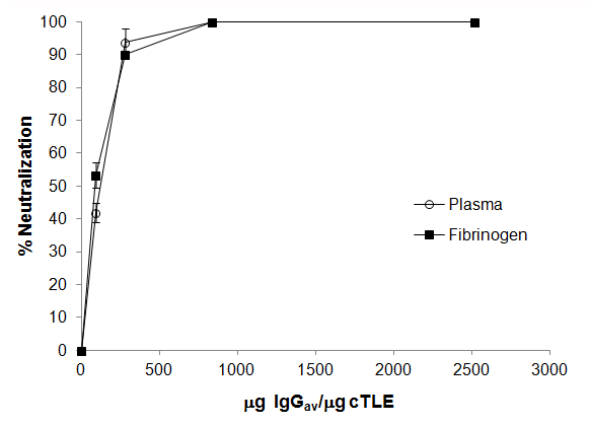
Figure 3. Neutralization of the coagulant activity of cTLE by IgG . Results are presented as mean ± S.D. av (n = 4). cTLE: crotalic thrombin-like enzyme.